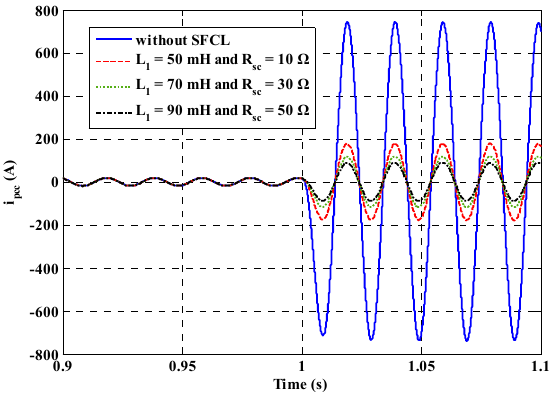
Figure 15. Fault current provided by the main network under the internal fault (A ‐ phase).